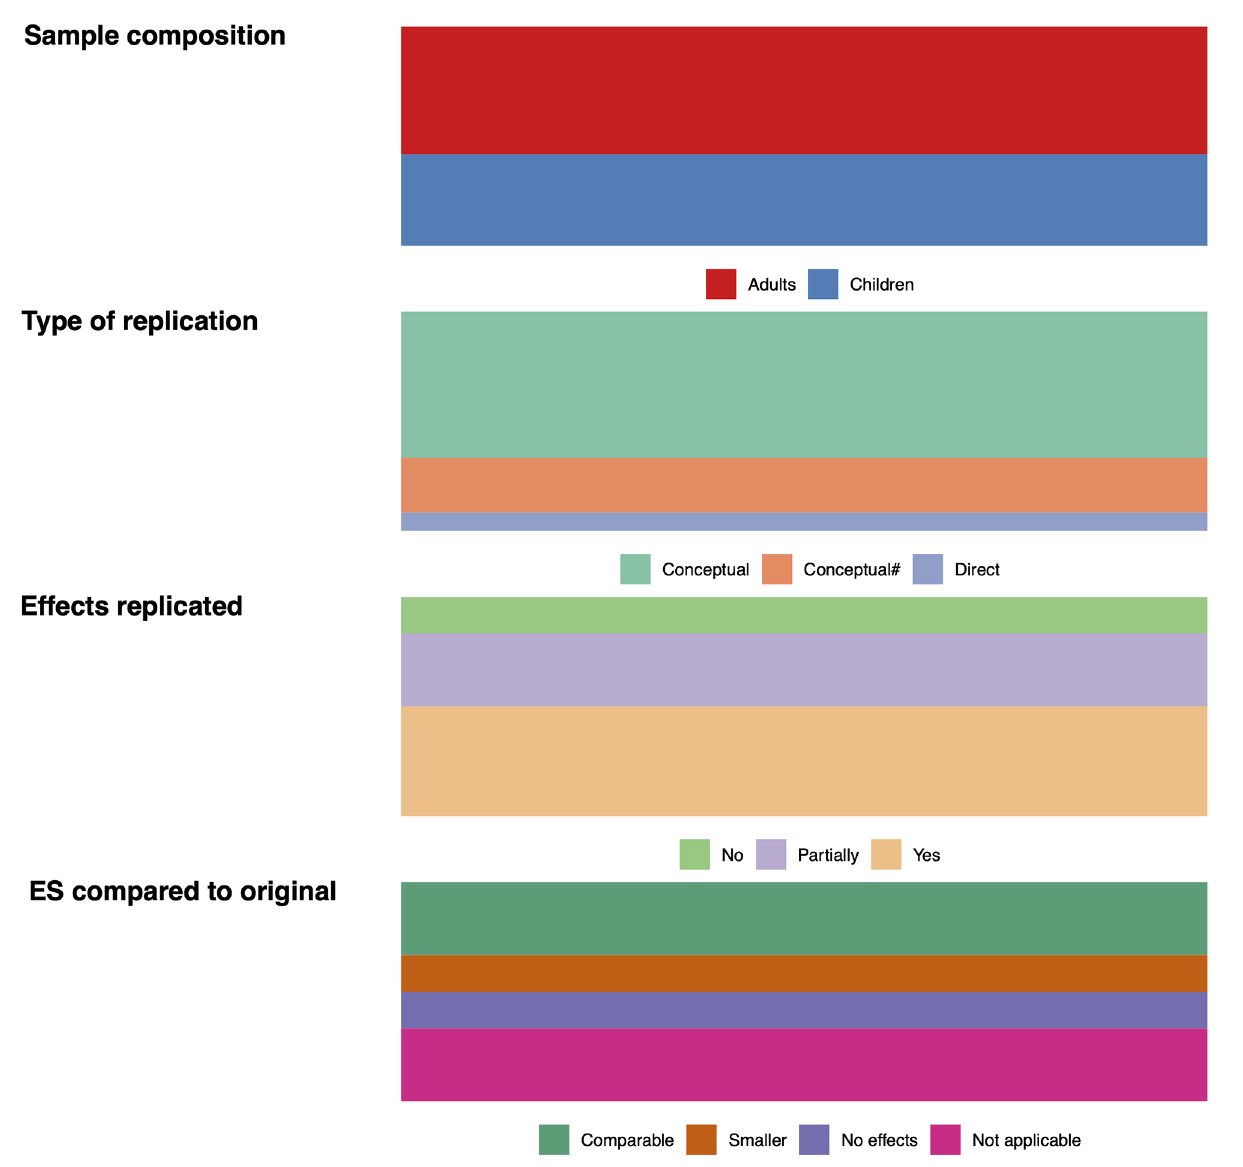
Graphical Summary of Contributions to the Special